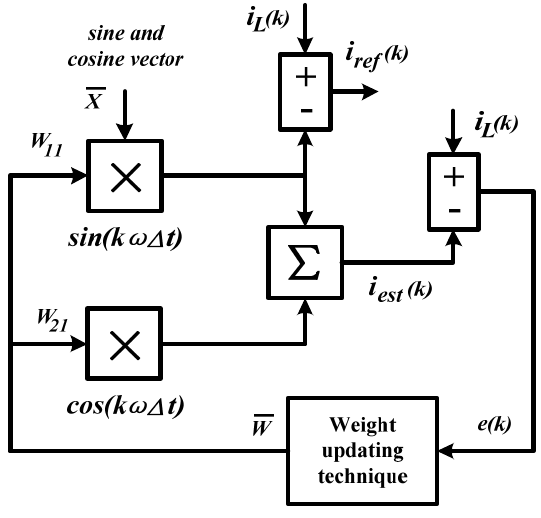
Figure 5. Control structure of a modified Artificial Neural Network (ANN) algorithm [20,33].